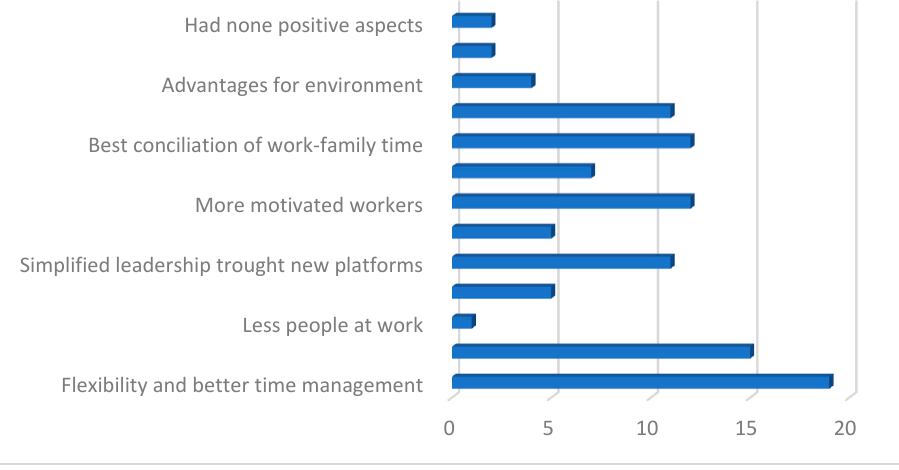
Figure 8. Positive aspects of telework.